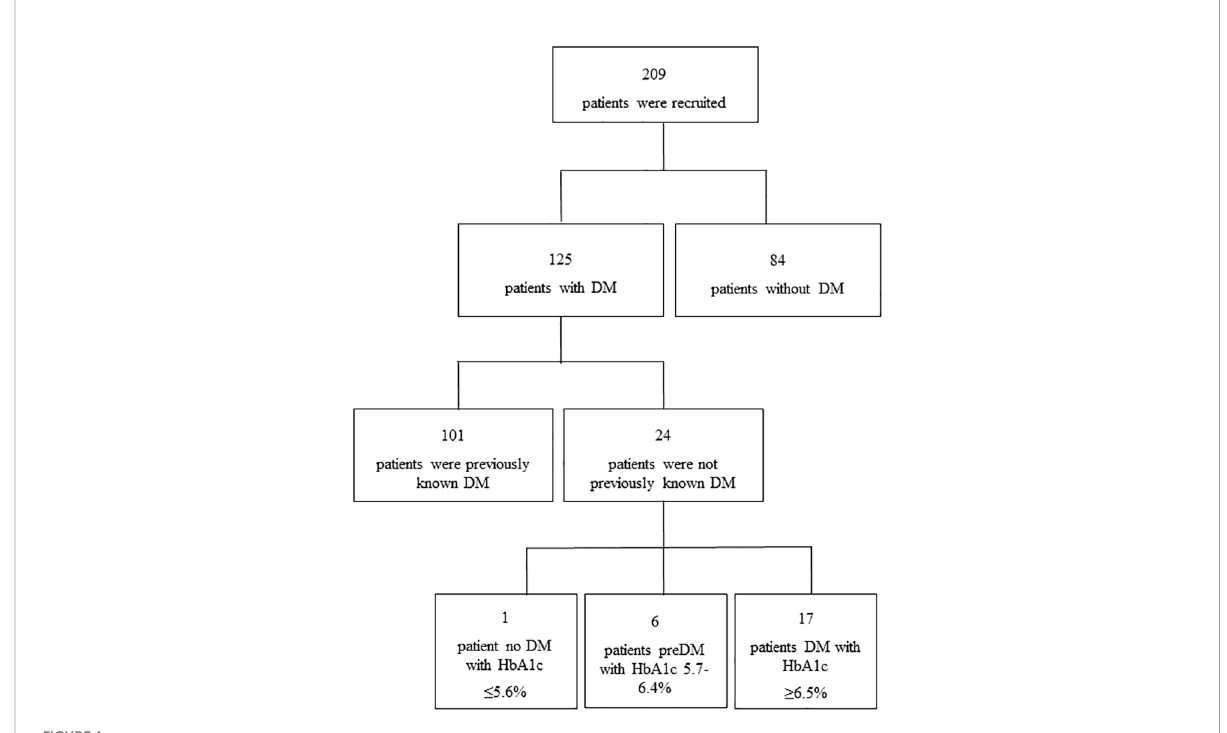
FIGURE 1 Flowchart of study